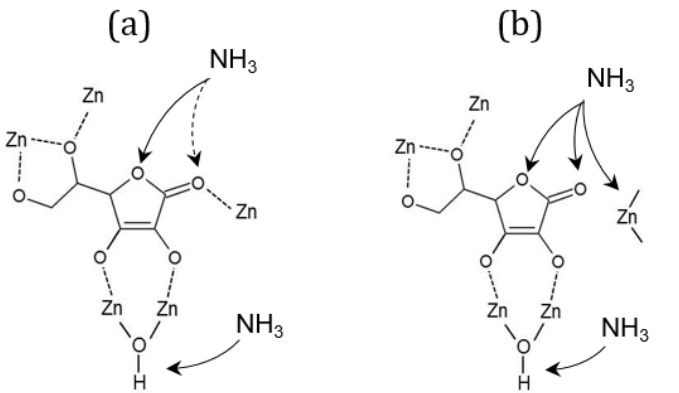
Figure 7. Scheme of the proposed acid binding sites for ammonia in ( a ) bioNICS1-FA-18-2h and ( b ) bioNICS1-PA-6-2h. ( b )